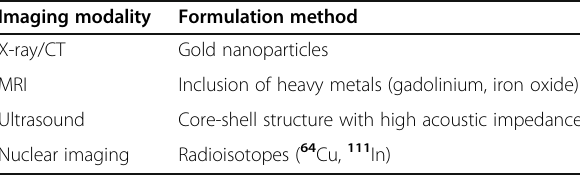
Table 1 Imaging modalities achieved using AuNP by